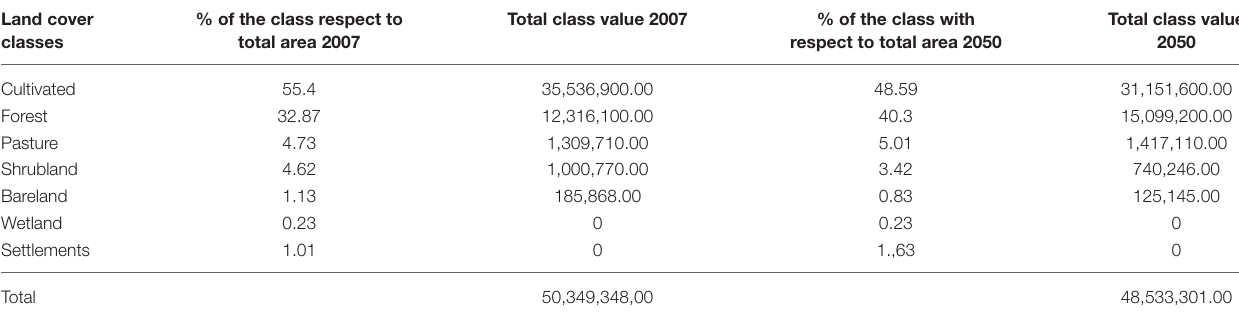
TABLE 4 | Variations in the total land values due to land cover changes in the Rivo case study. Land cover classes